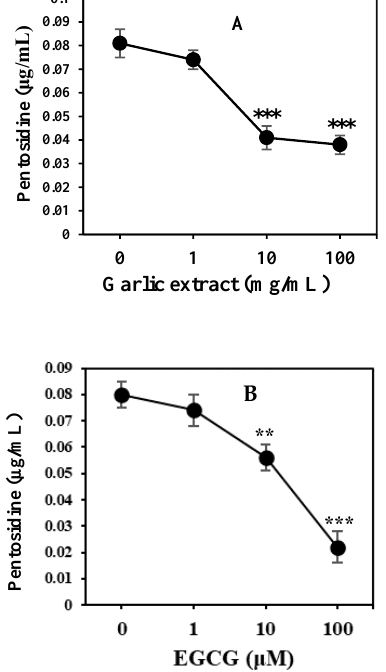
Figure 1. HSA samples (20 µ M) were incubated with 50 mM D-glucose in absence and presence of inhibitors garlic extract and epigallocatechin-3-gallate (EGCG) for 10 weeks. Inhibitory e ff ect of garlic extract (1–100 mg / mL) ( A ) and EGCG (1–100 µ M) ( B ) on the formation of advanced glycation end products (AGEs) were assayed. Results are presented as mean ± SD ( n = 3). At each time